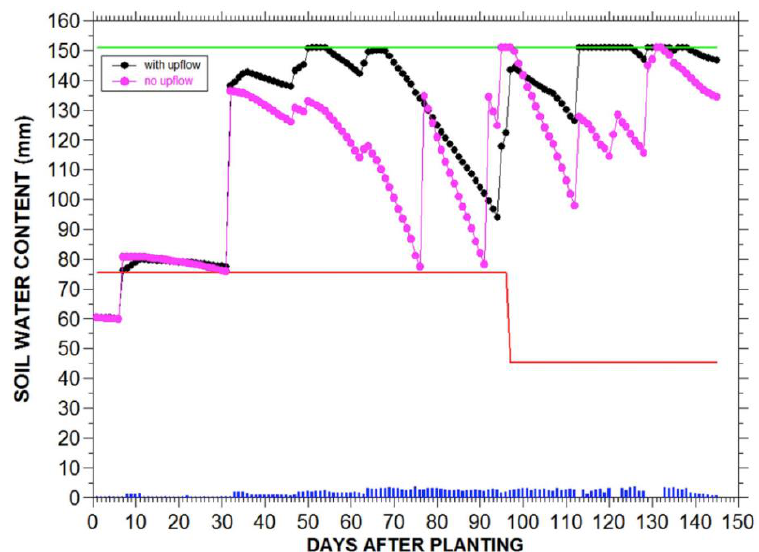
Figure 4. Simulated soil water content with and without capillary upflow. Bars at the bottom indicate daily upflow from the water table. The green line represents the drained upper limit, while the red indicates the target stress level (50% of drained upper limit until anthesis and 30% thereafter). With a water table present, irrigations were required 7 and 32 days after planting, whereas without a water table, two more irrigations were required at 77 and 92 days after planting.